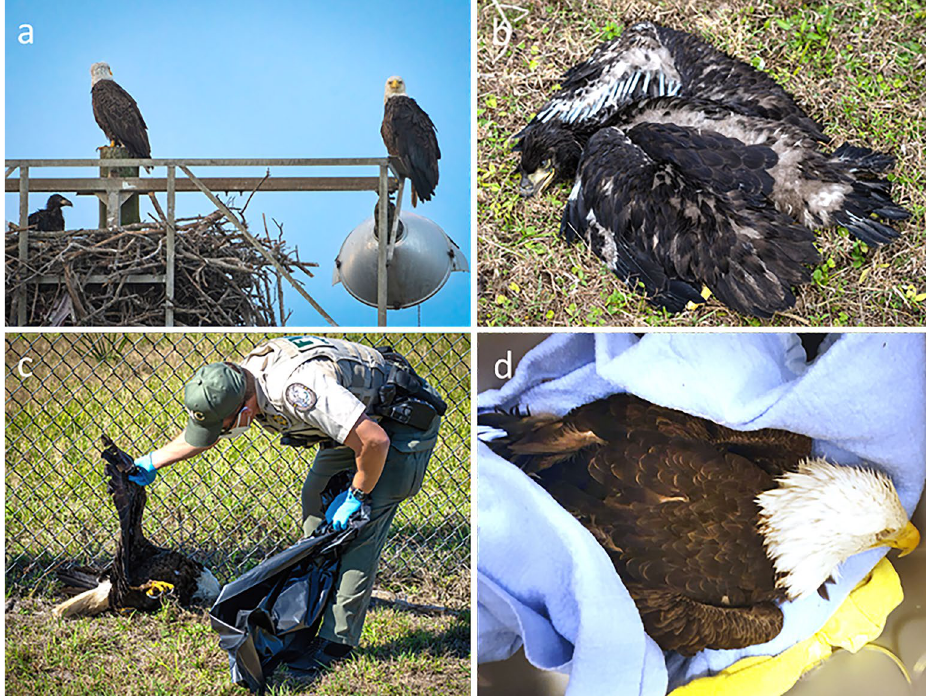
Figure 2. Images illustrating severe disease and mortality from H5 influenza A virus infection in bald eagles ( Haliaeetus leucocephalus ). ( a ) An attentive nesting pair of bald eagles (nest BE106) with an apparently healthy nestling on February 17, 2022, in Brevard County, Florida (photo by Bob Glover). ( b ) Nestling bald eagle from the same nest (BE106) taken February 18, 2022, after being found dead under the nest and later confirmed to have died from H5 IAV infection (photo by Bob Glover). ( c ) A Florida Fish and Wildlife Conservation Commission law enforcement officer collecting the carcass of the adult female from the same nest (BE106) after being found dead under the nest on February 24, 2022, after succumbing to H5 IAV infection (Photo by Bob Glover). ( d ) Adult bald eagle from Davidson County, North Carolina infected with H5 IAV and presented to a wildlife rehabilitation facility with severe neurologic signs (e.g., severe lethargy, seizures, partial paralysis); the eagle was administered oxygen, subcutaneous fluids, antibiotics, diazepam (valium®) but died the following morning (photograph by Jackie